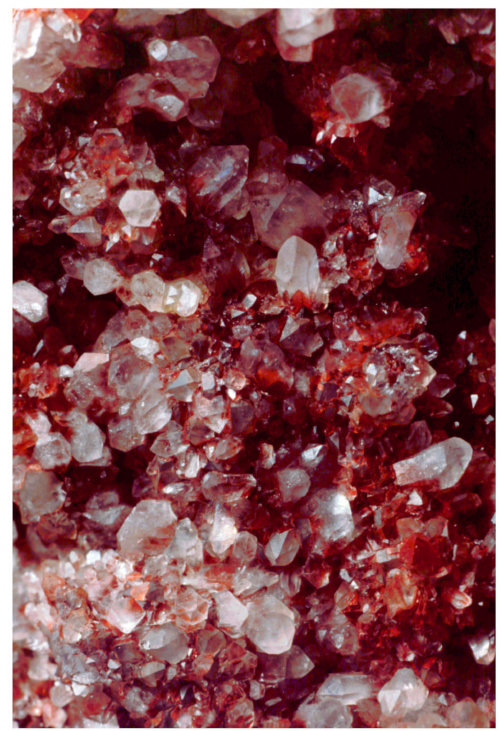
Figure 25. Quartz with included hematite (cherry quartz), Bowman prospect. Field of view, 7 cm. Chamberlain Collection, NYSM C4672.